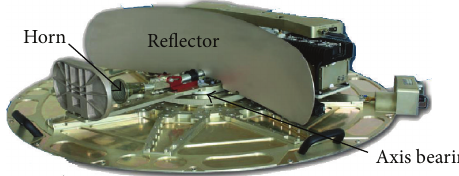
Figure 2: A low-profile design of mechanical dish antenna to fit the limited design space in the dome [21] (used courtesy of MOST Corporation